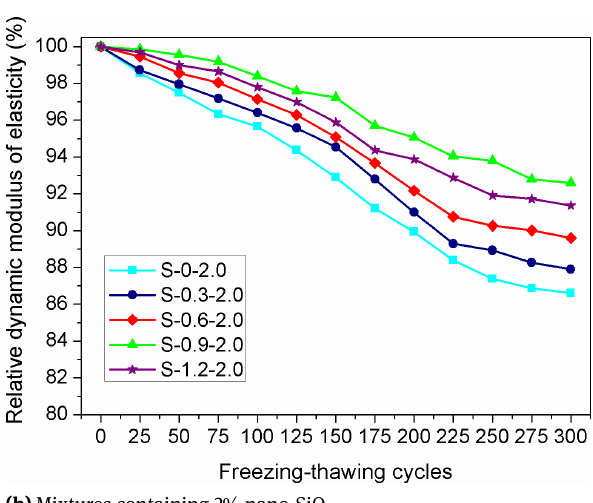
Figure 5: Effect of PVA fiber on relative dynamic elastic modulus